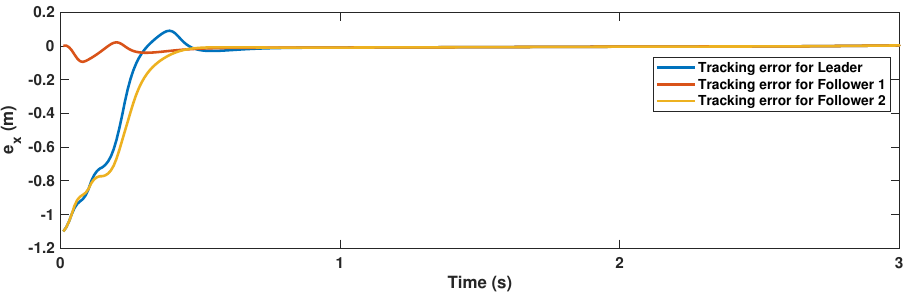
Figure 14. Path 3: The tracking error on the X-axis.